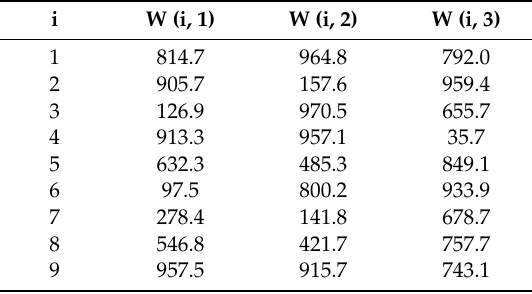
Figure 4. ( a ) Synaptic weight changes during Hebbian training; and ( b ) output neuron responses during Hebbian training. Table 4. Initial random weight W (i, j) (mV).